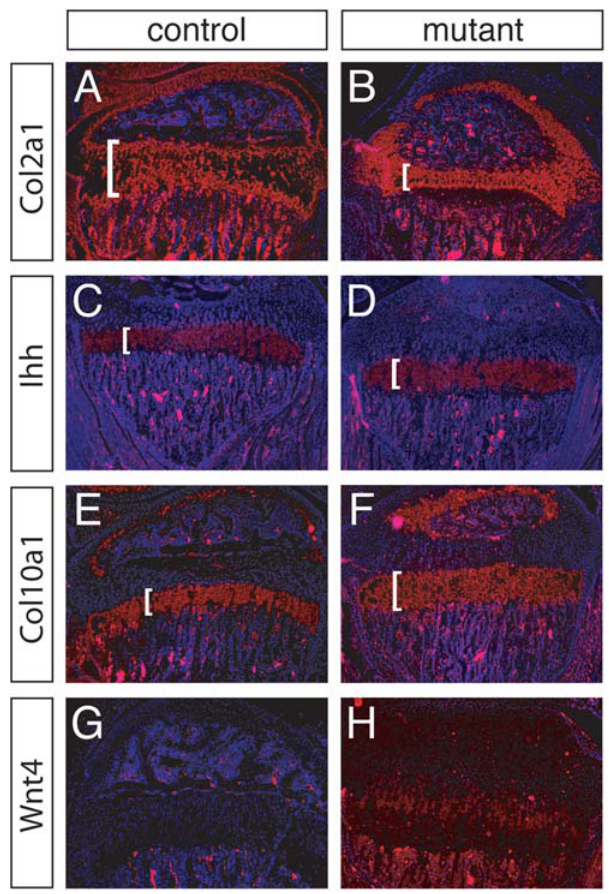
Figure 6. Section RNA in situ hybridization of tibial growth plates of 3-week-old animals. Molecular marker analysis of tibiae of 3-week-old R26 floxneoWnt4 heterozygous control (A, C, E, G) and R26 floxneoWnt4 ; Col2a1- Cre mutant (B, D, F, H) mice. Col2a1 marks proliferating and prehypertrophic chondrocytes; Col10a1 marks prehypertropic chondro- cytes; Ihh marks prehypertropic and hypertropic chondrocytes. Brackets mark relevant regions. Wnt4 hybridization is undetectable in the growth plate of the control, whereas Wnt4 transcripts are detected throughout the growth plate of the mutant.